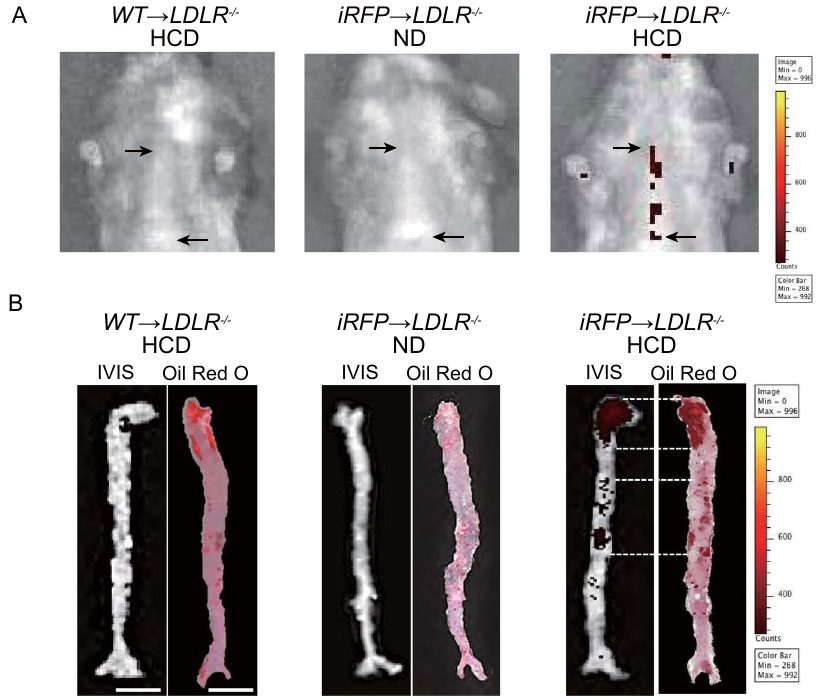
Figure 2. iRFP signal is expressed specifically in the plaques of HCD-fed iRFP → LDLR − / − mice. In vivo and ex vivo iRFP signals were identified by the IVIS under 710 nm and 760 nm excitation and emission wavelengths, respectively. The acquired IVIS images were adjusted to 268 (minimum) and 992 (maximum) counts of the color scale by Living Image software. ( A ) IVIS images of the thoracic area in HCD-fed WT → LDLR − / − , ND- fed iRFP → LDLR − / − and HCD-fed iRFP → LDLR − / − . The thoracic signal (marked by arrows) was observed only in the HCD-fed iRFP → LDLR − / − mice. ( B ) The comparison between ex vivo IVIS images and ORO staining of dissected aortas from the HCD-fed WT → LDLR − / − , ND-fed iRFP → LDLR − / − fed and HCD-fed iRFP → LDLR − / − mice. All imaging was performed after 8 weeks of feeding (scale bar, 5 mm). The data are from one representative experiment of at least two independent